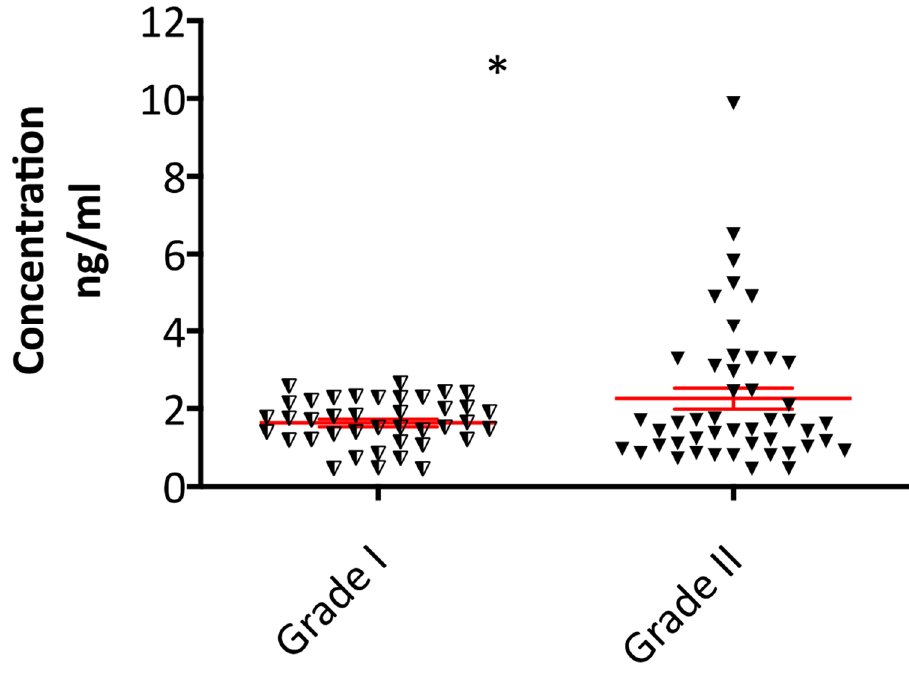
Figure 3. Higher plasma concentration of Fibulin-2 in grade II ( n = 47) compared to grade I ( n = 40) meningioma patients. Data presented as mean ± SEM, * p < 0.05.